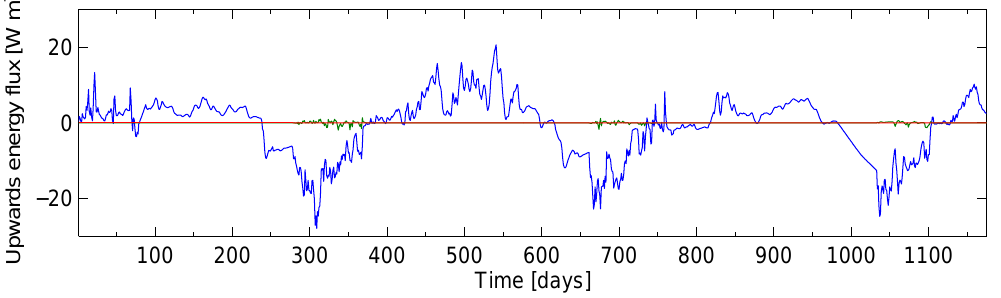
Fig. 11. Mean energy flux at the Bayelva site averaged over the depth of the profile. Blue: conductive, green: convective by liquid water, red: convective by water vapor.